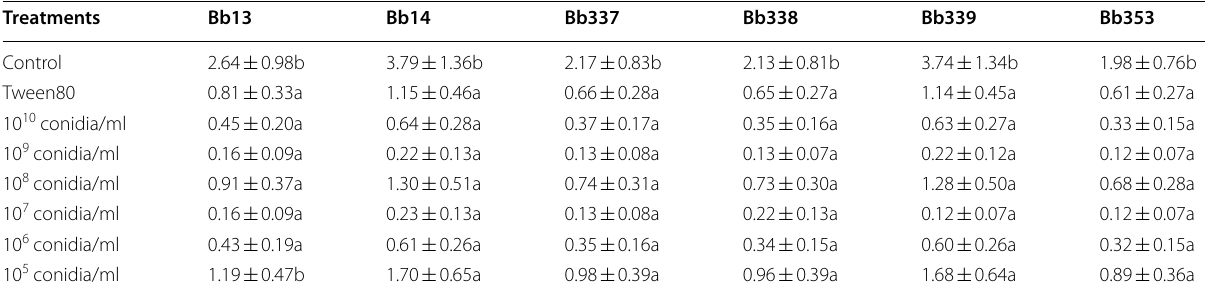
*Means within rows followed by the same letters are non-significantly different at α